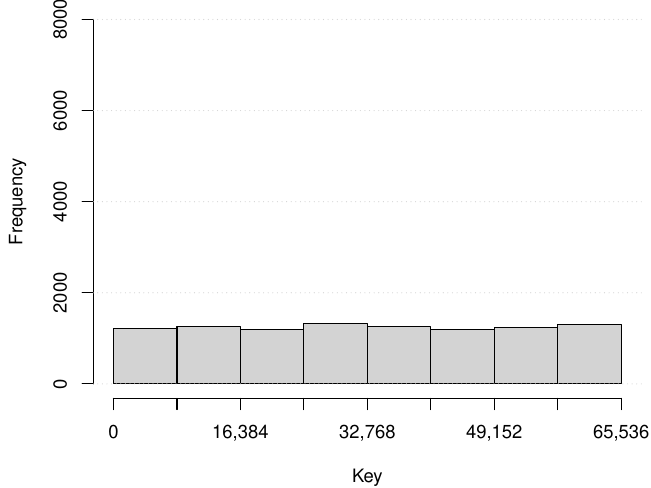
Figure 6. The number of messages among virtual nodes for one